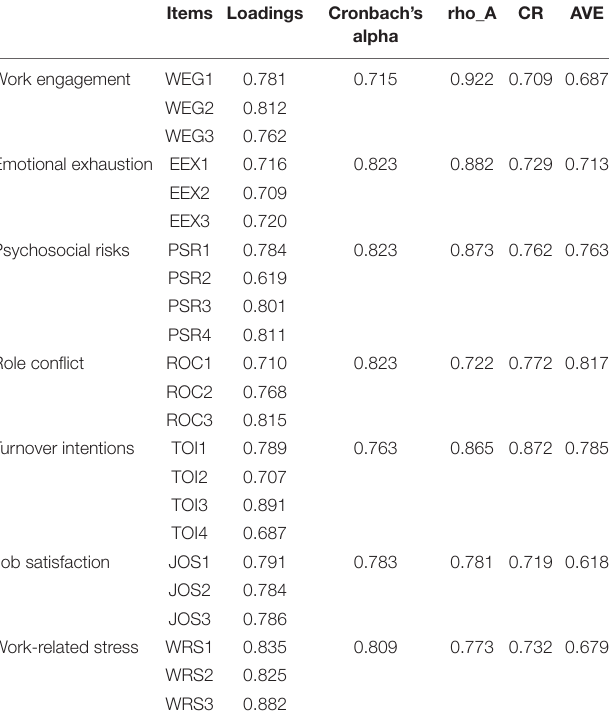
TABLE 3 | Reliability and validity